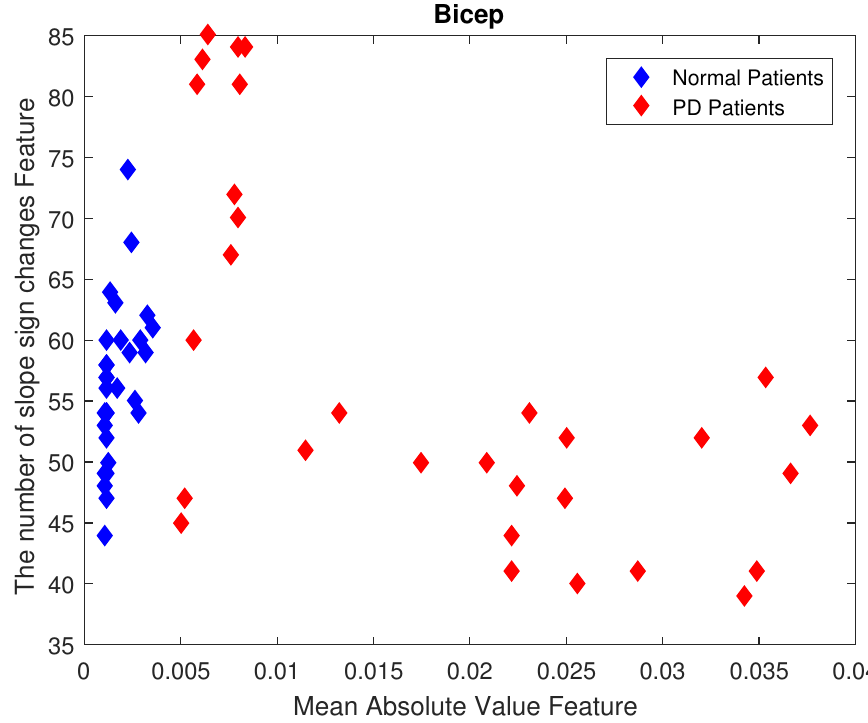
Figure 11. Two-dimensional scatter plot of slope sign changes (SSC) feature vs. mean absolute value (MAV) feature of biceps brachii surface EMG (sEMG) sensor for normal and PD